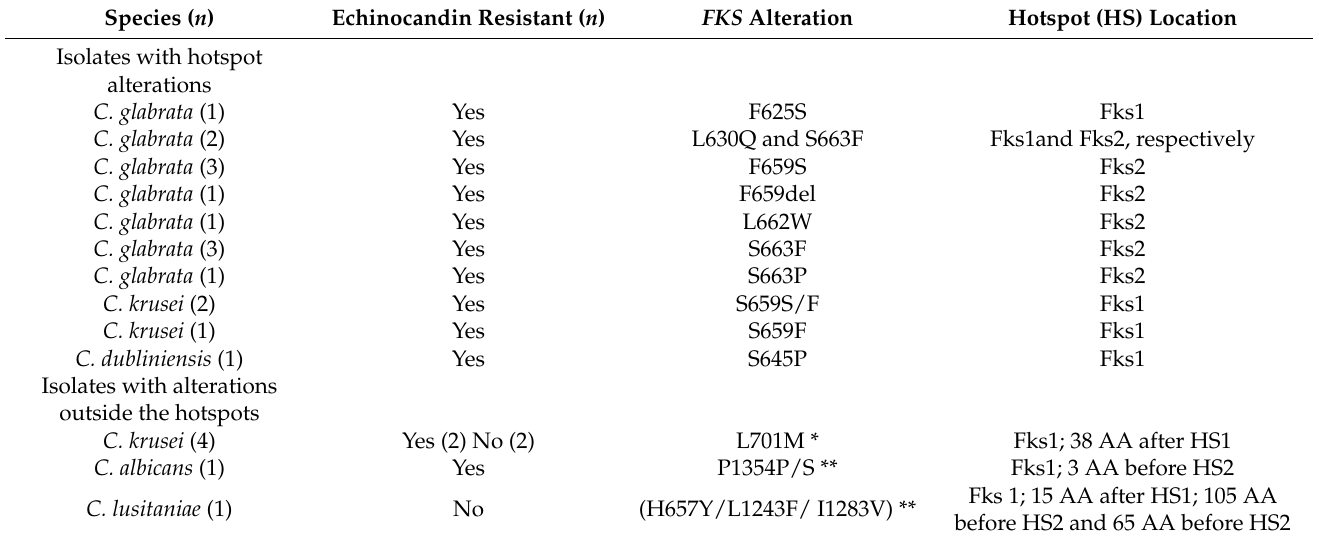
Table 4. Identified FKS amino acid (AA) alterations. Unless stated otherwise, the detected alterations are known to be associated with echinocandin